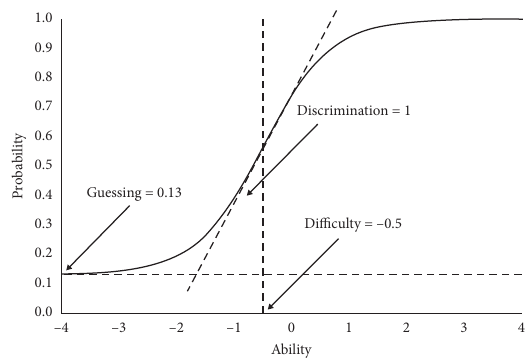
Figure 2: Item Response